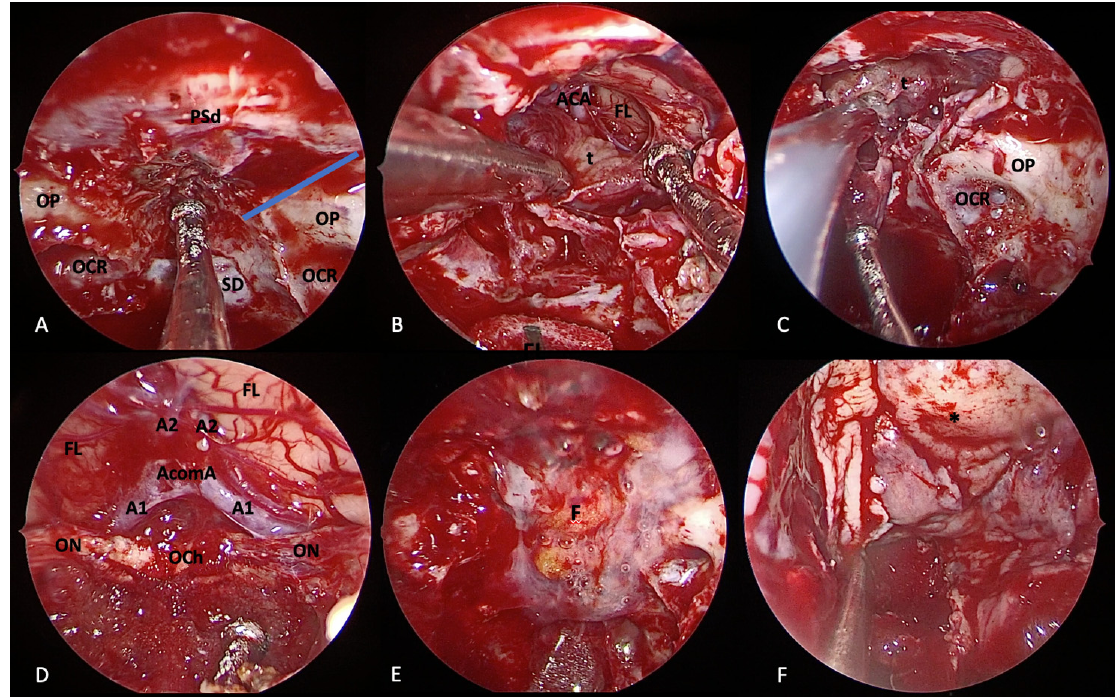
Figure 7. Extended endoscopic endonasal transplanum/transtuberculum approach for removal of tuberculum sellae meningioma. ( A ) Margins of bone removal: laterally, the optic nerves and the optocarotid recess; inferiorly, the sellar floor; anteriorly, the bone removal is tailored on tumor extension. Extracapsular dissection ( B ) and internal debulking ( C ) of the tumor. Surgical field view after tumor removal ( D ). Closure is performed using fat ( E ), nasoseptal flap ( F ), and fibrin glue. Tumor (t); dura of the planum sphenoidale (PSd); optic protuberance (OP); optocarotid recess (OCR), sellar dura (SD); frontal lobe (FL); anterior cerebral artery (ACA); optic nerve (ON); optic chiasm (OCh); fat (F); nasoseptal flap